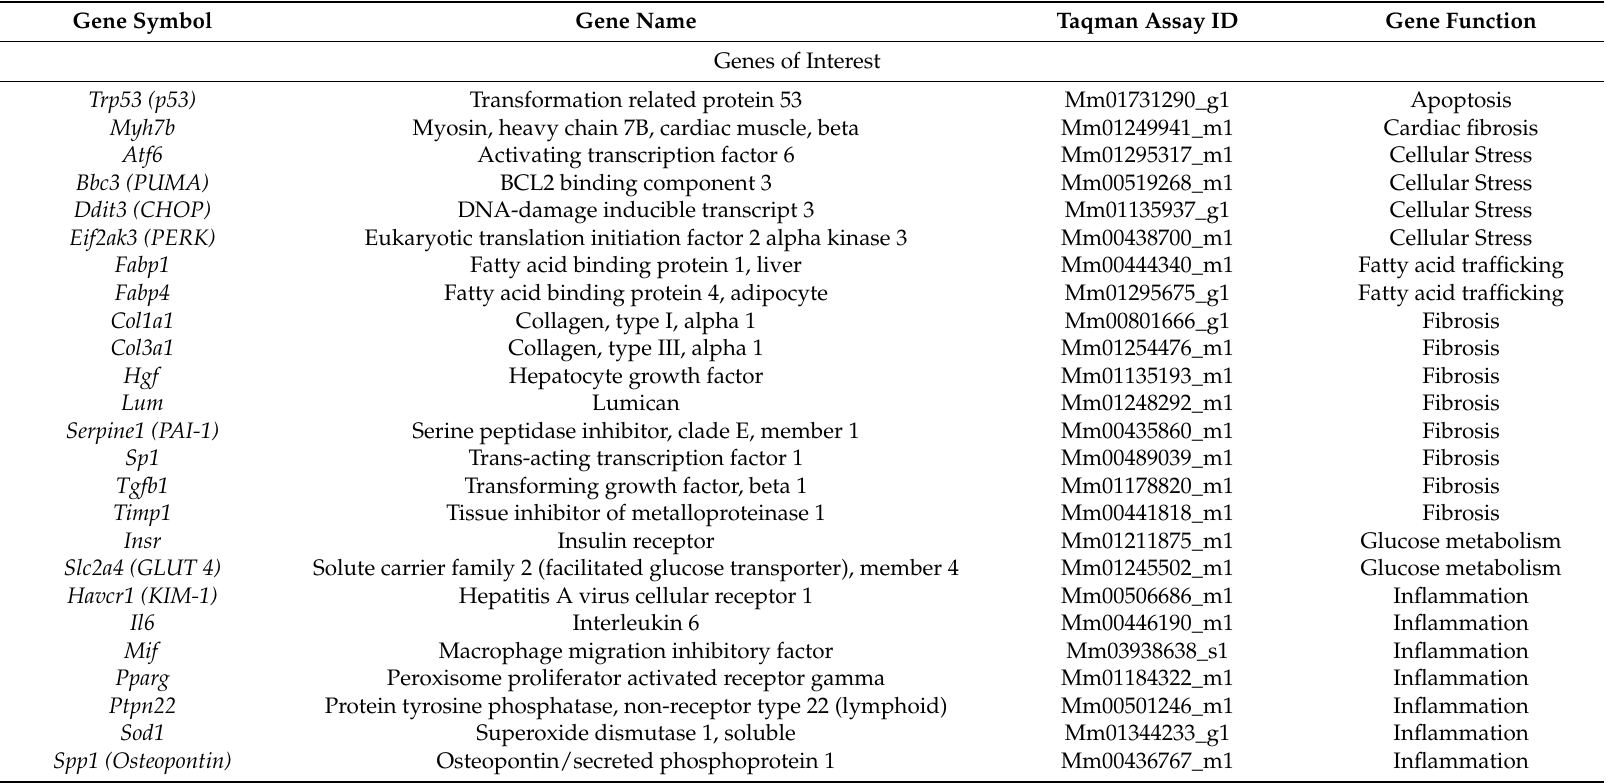
Table 1. Description of Genes of Interest and Reference